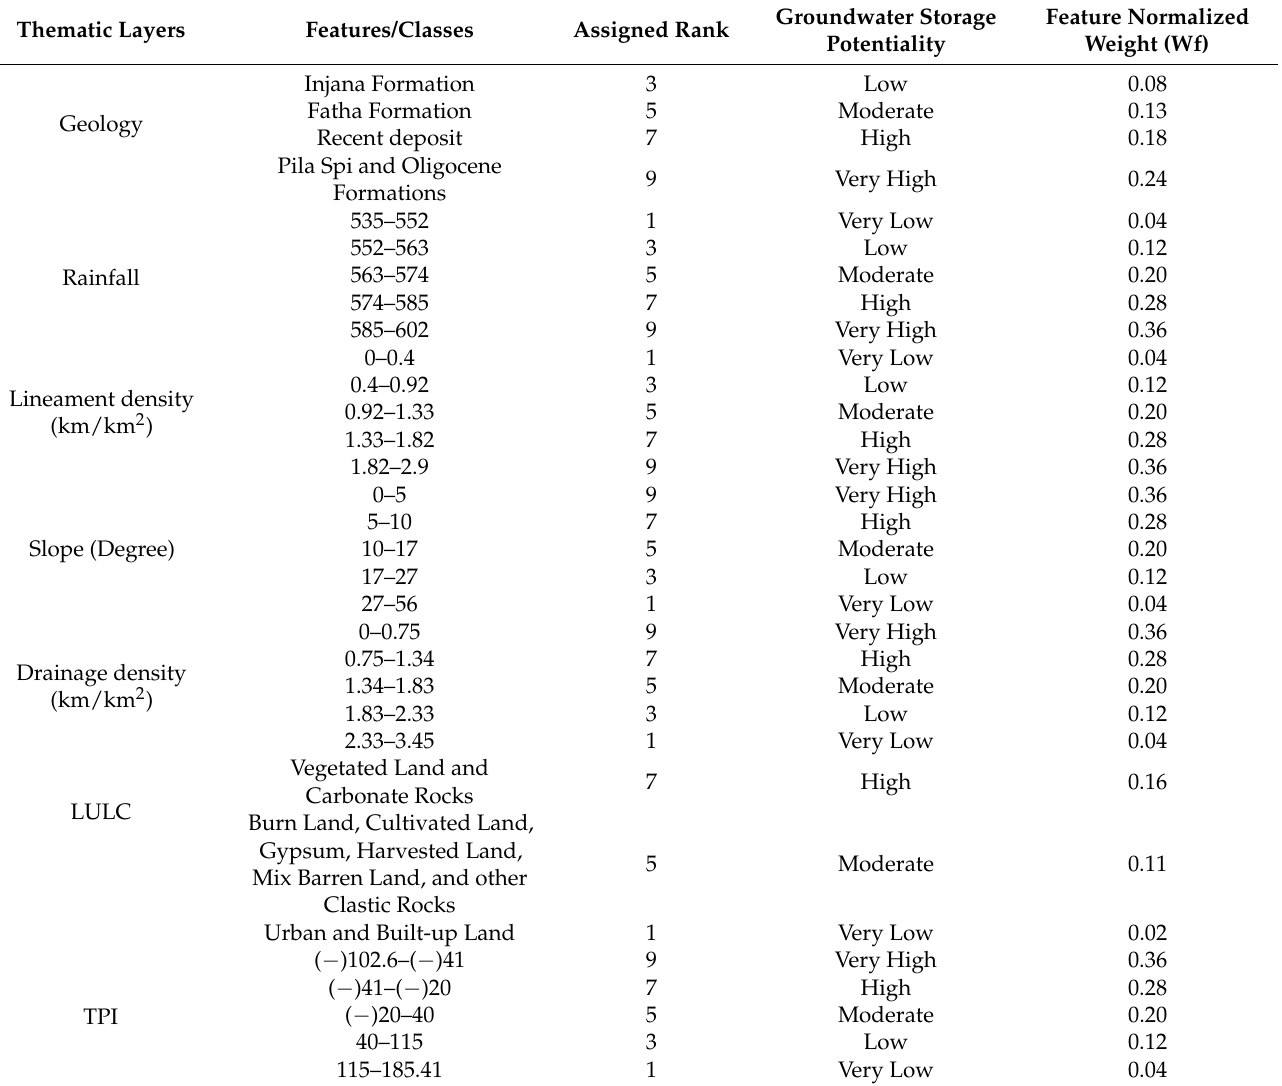
Table 5. Weights of features/classes of thematic maps for potential groundwater